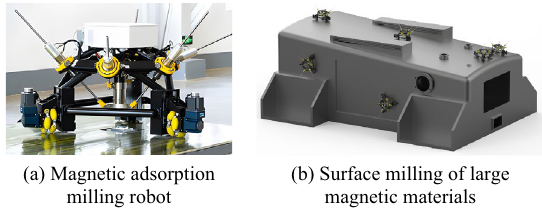
Figure 24 Magnetic adsorption milling robot and its